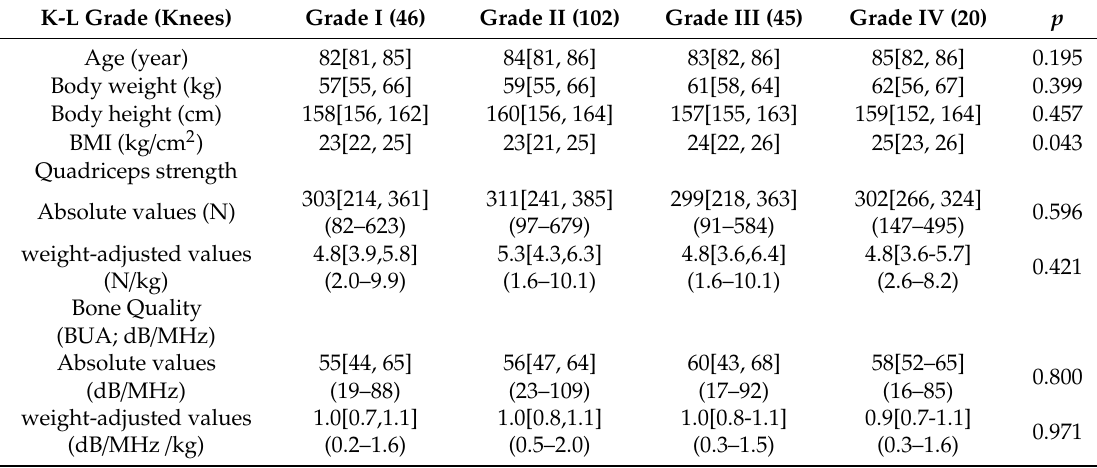
Table 1. Isometric quadriceps strength and bone quality of the calcaneus for men aged 80 years or older ( n = 108 patients, 213